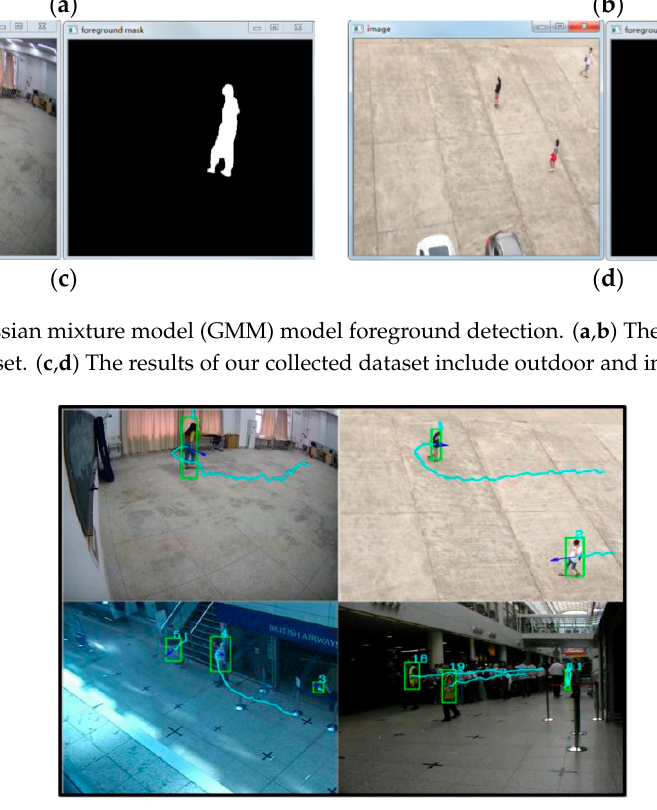
Figure 11. Target tracking and detection. Table 1. The accuracy of target detection and tracking.